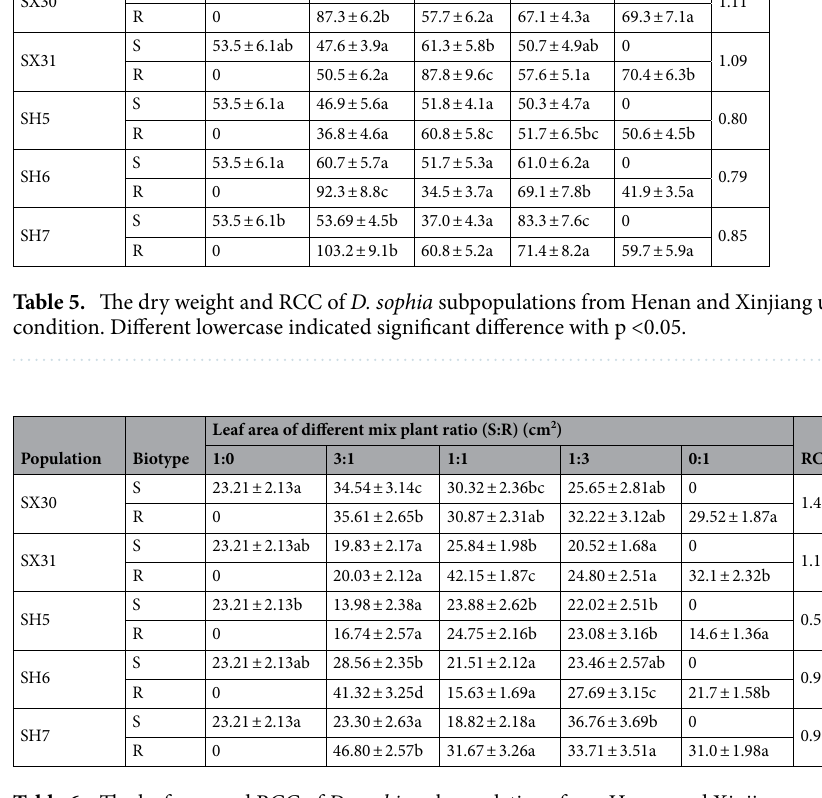
Table 6. The leaf area and RCC of D. sophia subpopulations from Henan and Xinjiang under admixture condition. Different lowercase indicated significant difference with p